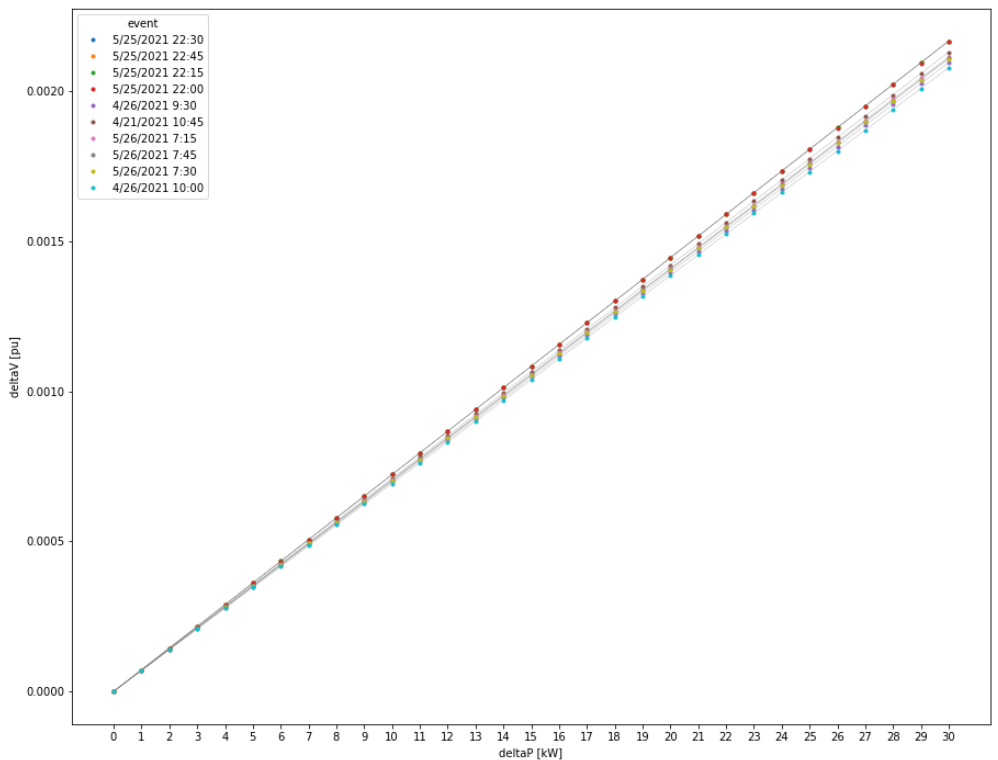
Figure 11. Dependences of increase in voltage on defined location on changes in consumption of flexibility provider/asset (Cons30) for different grid states.